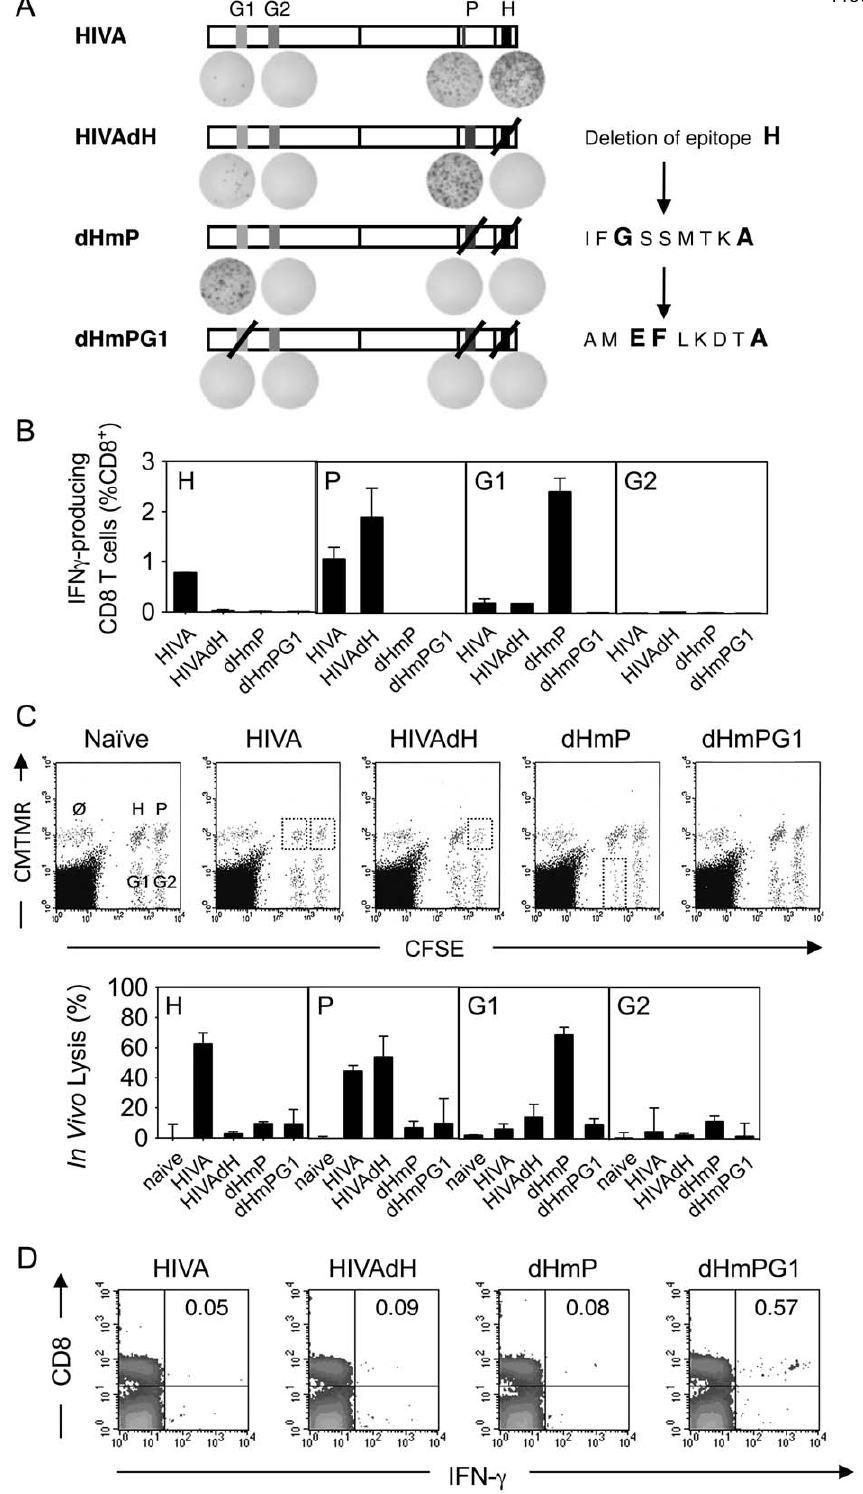
Figure 2. Serial up-ranking of epitopes. A) Groups of 4 BALB/c mice were immunized 2x i.m. with 100 m g of DNA at a 2-wk interval. Two wk later, splenocytes were assessed in an ELISPOT assay for production of IFN- c upon re-stimulation with peptides indicated above. Shown are schematic diagrams of HIVA and the three modified immunogens with representative examples of the ELISPOT well images. B) Mice were immunized as in A and 4 wk later, splenocytes were assessed in an ICS assay to measure CD8 + T cells secreting IFN- c upon re-stimulation with peptide indicated in the top left corner. Group means 6 SD are shown. C) Identical groups of mice were assessed for cytolytic activity in an in vivo lysis of syngeneic peptide- pulsed cells transferred into naı¨ve or vaccinated animals. Representative examples of dot plots are shown (top) and the peptide-specific lyses are expressed as a group mean 6 SD (bottom). D) Groups of 3 BALB/c mice were immunized 3x with 100 m g of DNA indicated above the dot plot in 2-wk intervals and the designated NPP peptide-specific responses were assessed by IFN- c ICS 2 wk later. The FACS plots are representative examples with IFN- c producing cells as a percentage of CD8 + splenocytes shown in the top right panels. All experiments were repeated at least once.